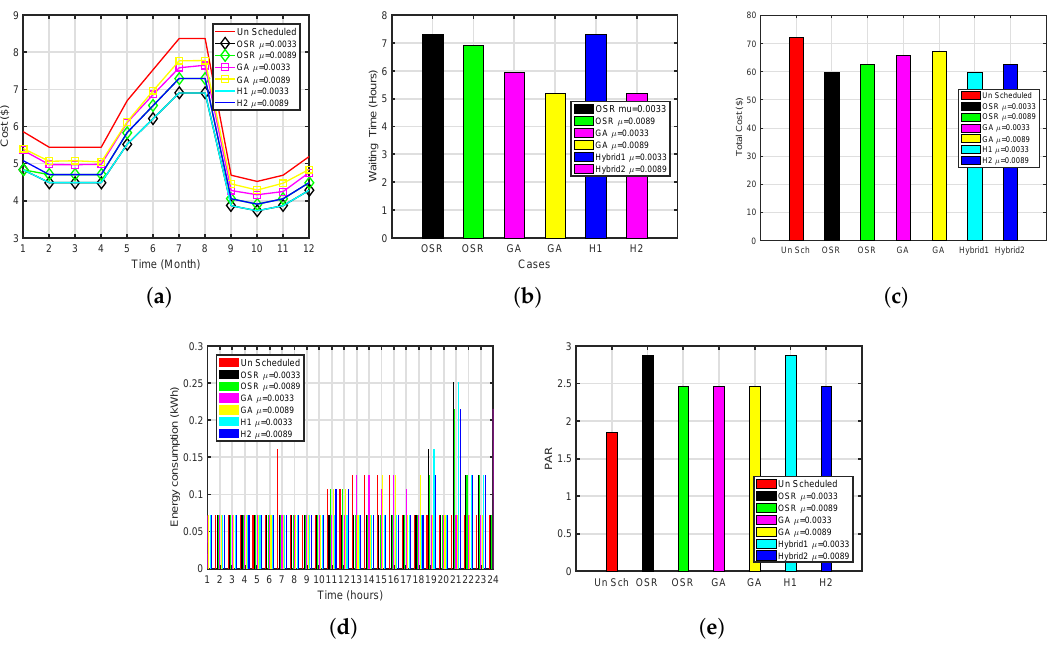
Figure 6. Hybrid Plots for Refrigerator (OSR-GA). ( a ) Monthly Cost of Refrigerator (OSR-GA), ( b ) Waiting Time of Refrigerator (OSR-GA), ( c ) Total Cost of Dish Washer (OSR-GA), (d ) Energy Consumption of Refrigerator (OSR-GA), ( e ) PAR of Refrigerator